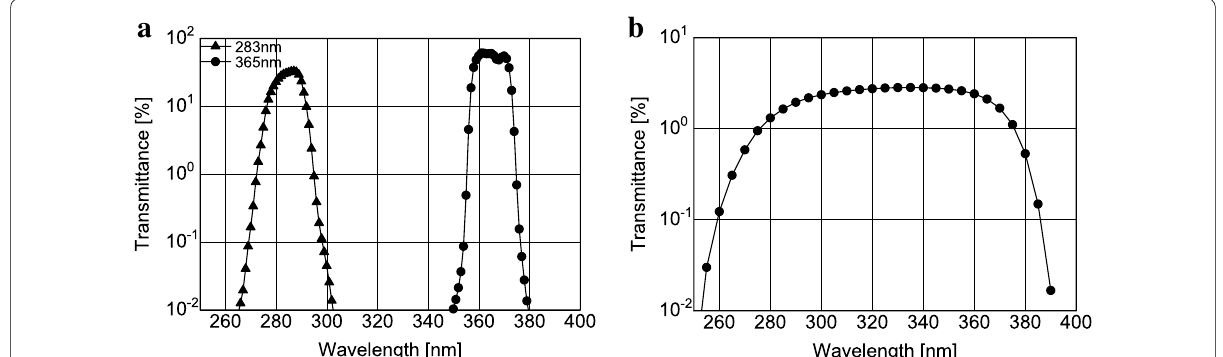
Fig. 3 a Transmittance of the interference filters for the 365‑ and 283‑nm channels (circles and triangles) and b transmittance of